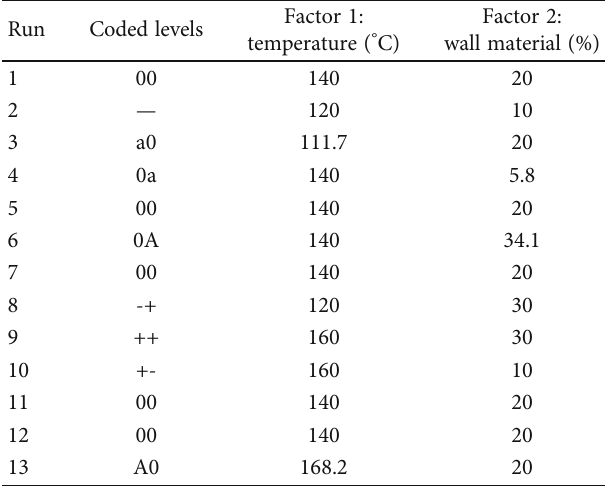
Table 2: Central composite design used to optimize the microencapsulation process of oregano ( Lippia graveolens )